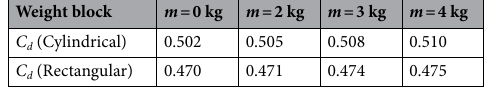
Table 4. H = 0.05 m, stable value of resistance